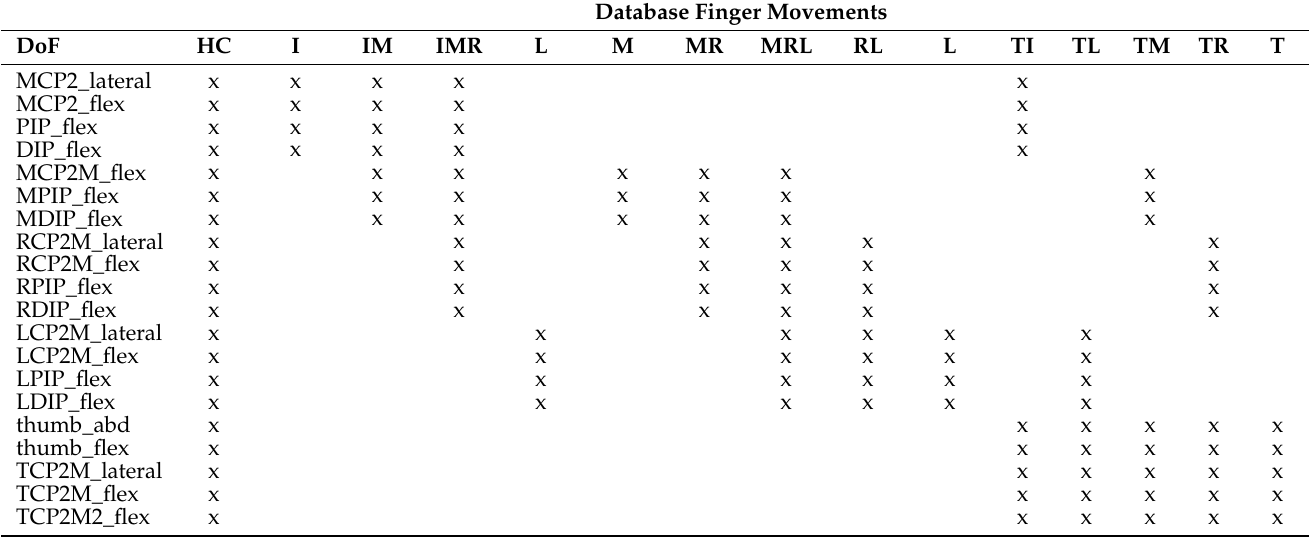
Table 3. Relationship degrees of freedom (DoFs) of the Opensim model of the wrist with the movements of the